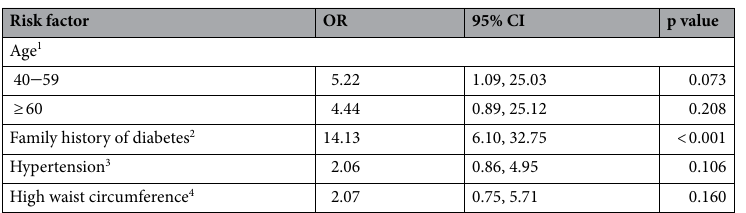
Risk factor OR 95% CI p